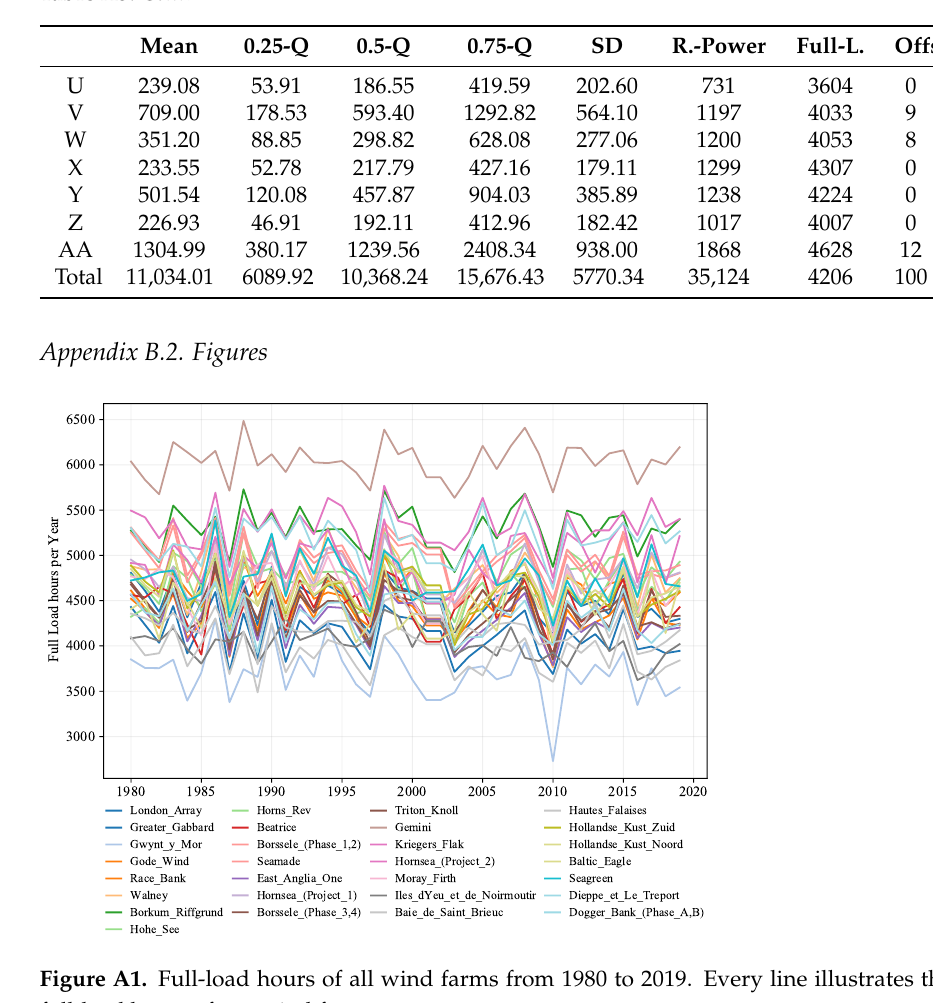
Figure A1. Full-load hours of all wind farms from 1980 to 2019. Every line illustrates the yearly full-load hours of one wind farm.